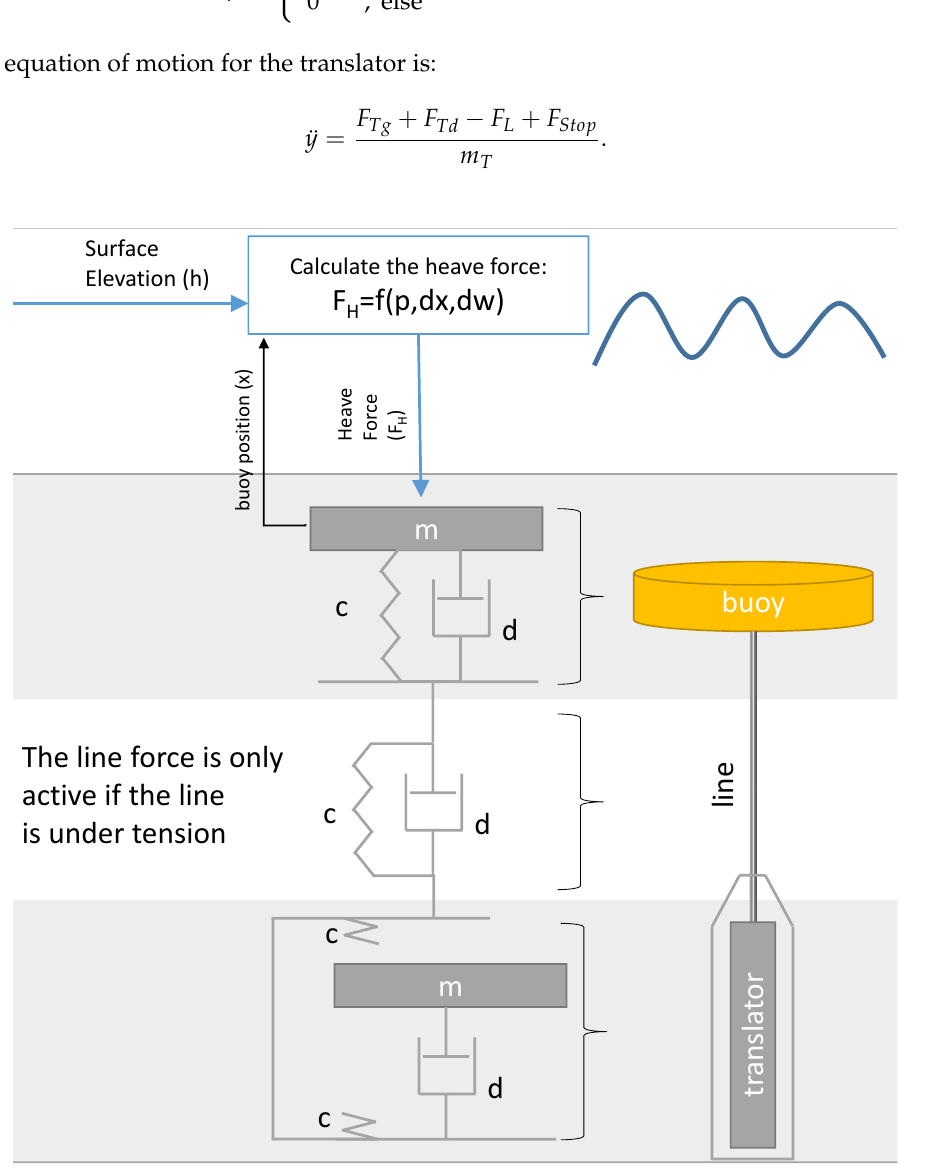
Figure 3. Block diagram of the model, c is the stiffness of the spring, d the damping coefficient and m the